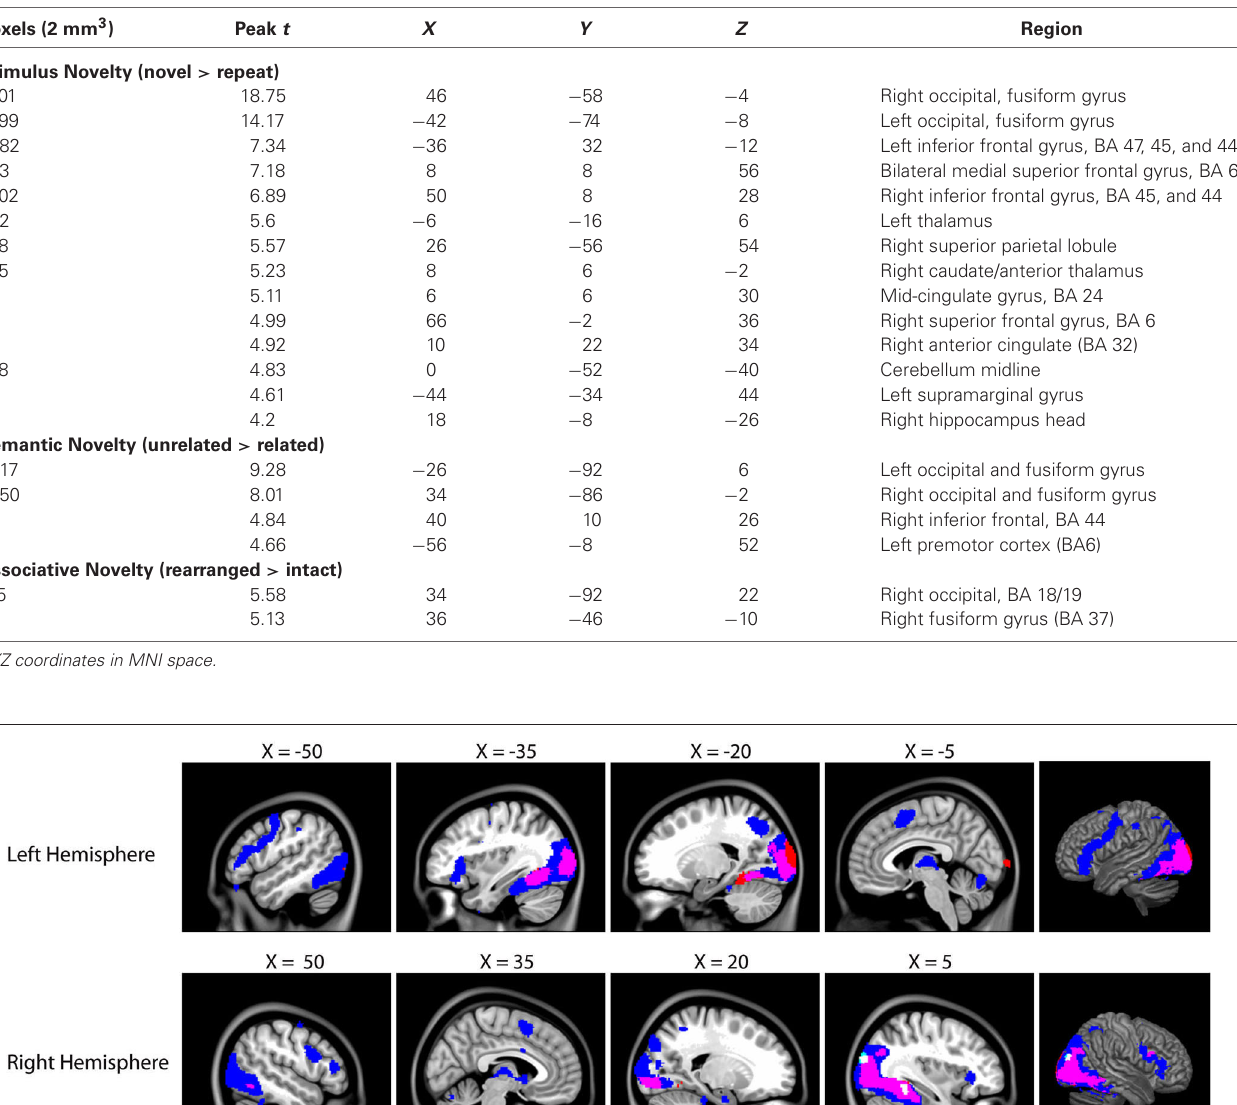
Table 1 | fMRI activations for novelty analysis .